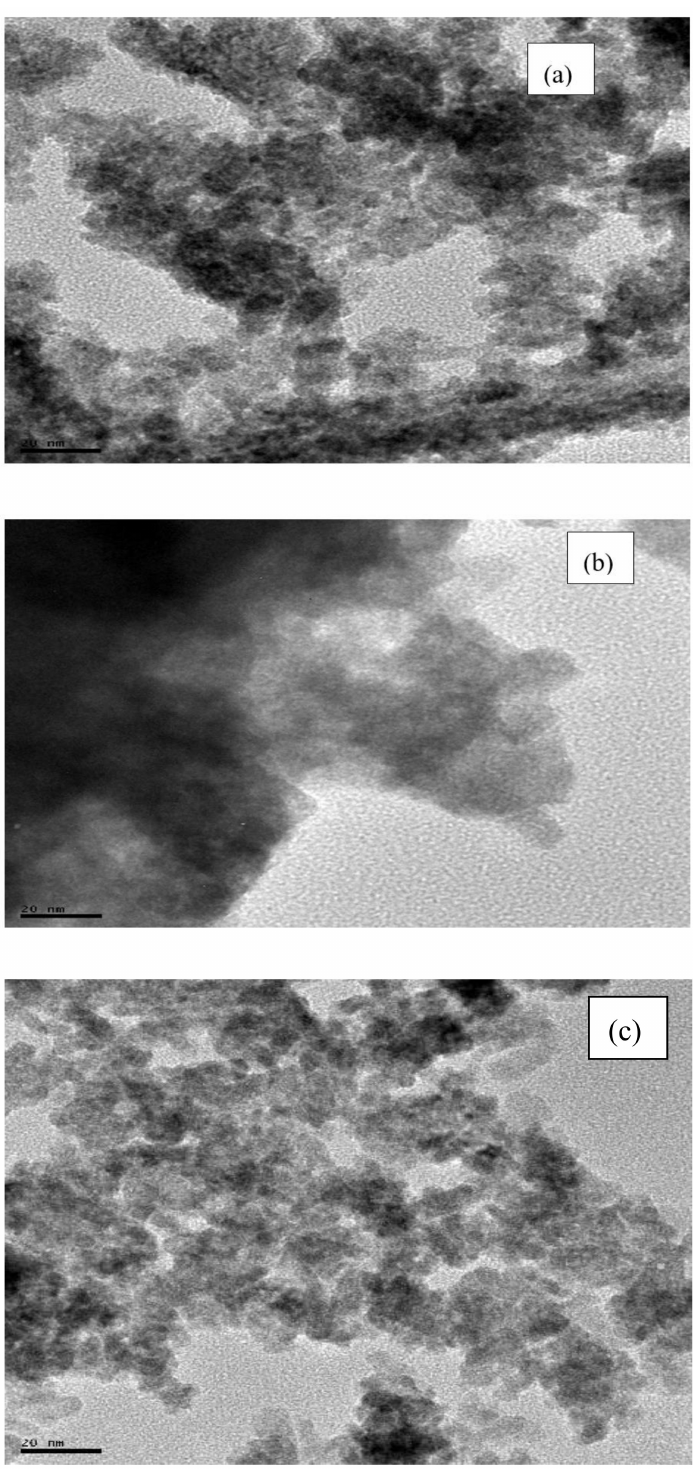
Figure 7. TEM images of ( a ) GPE / ZnO NPs, ( b ) LPE / ZnO NPs ( c ) OPE / ZnO